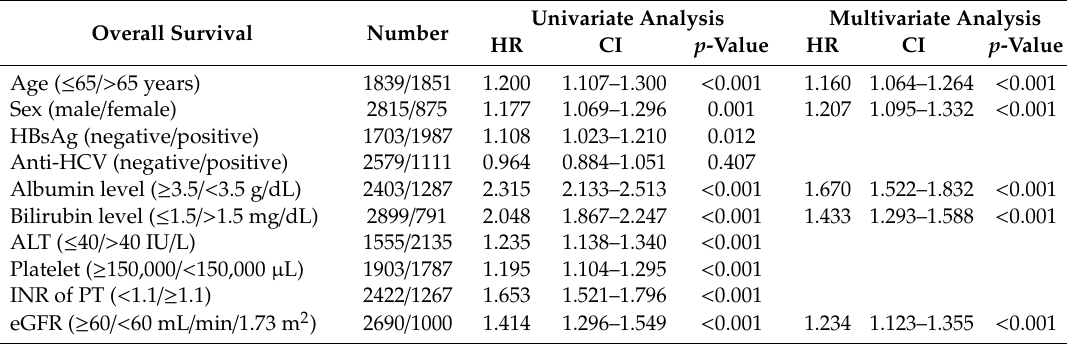
Table 2. Univariate and multivariate survival analysis of all study patients ( n = 3690).